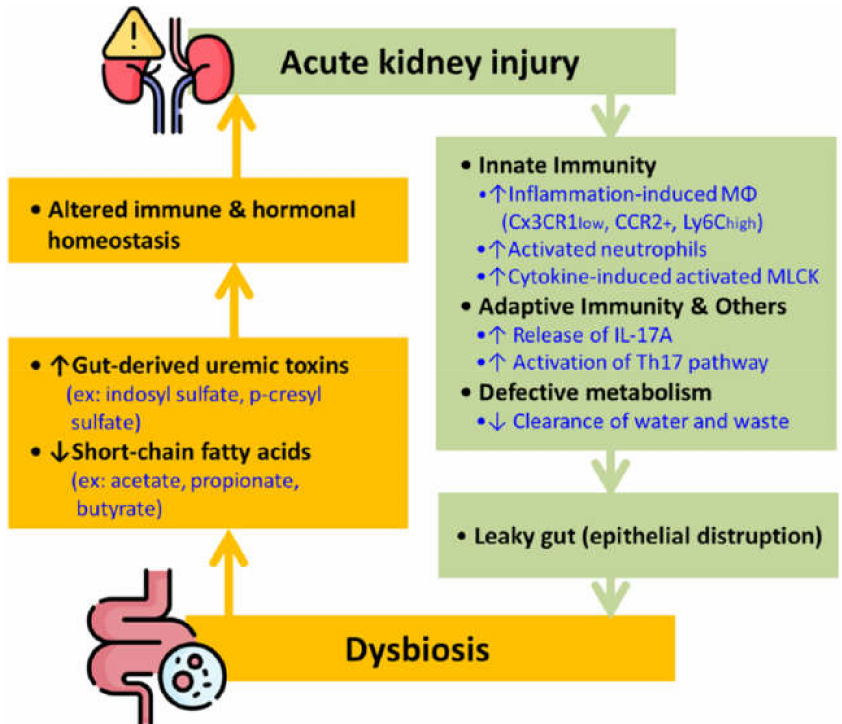
Figure 1. The bidirectional interplay between AKI and gut dysbiosis. Note: AKI prompts innate and adaptive immunity, disrupting the epithelial barrier and causing the gut microbiome imbalance. Dysbiosis can also cause breaking of immune and hormonal equilibrium that further worsens kidney function. Abbreviation: IL = interleukin; M ϕ = macrophages, MLCK = myosin light chain kinase; Th17 = T helper type